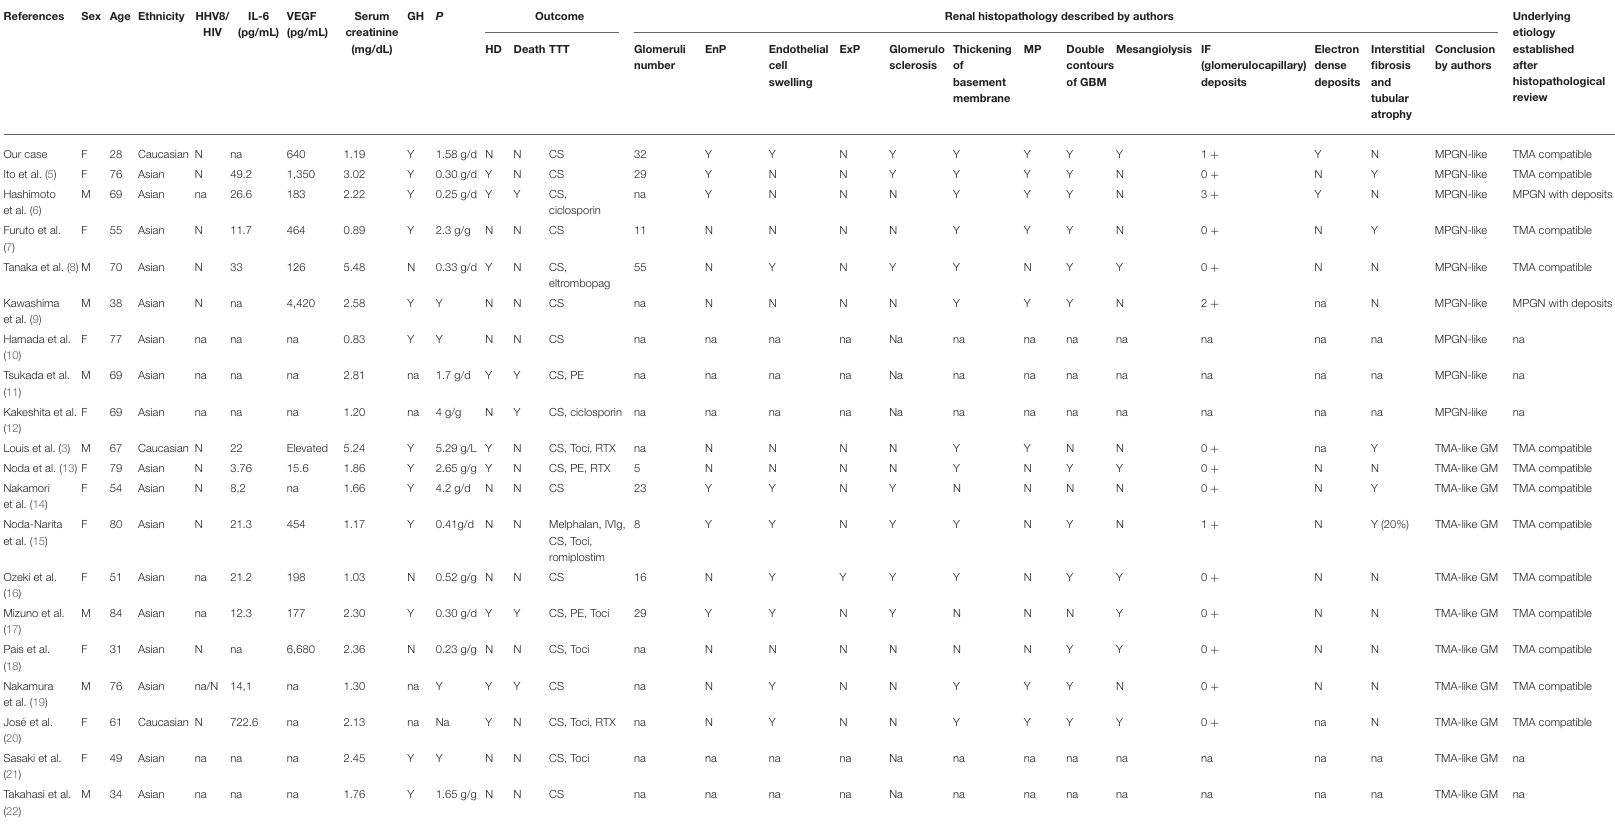
TABLE 1 | All reviewed cases of TAFRO syndrome with renal